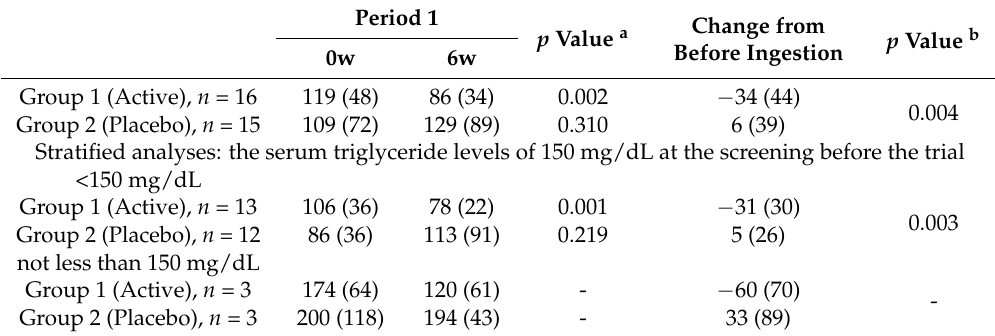
Table 6. Comparison of serum triglyceride concentrations (mg/dL) in active and placebo groups. Period